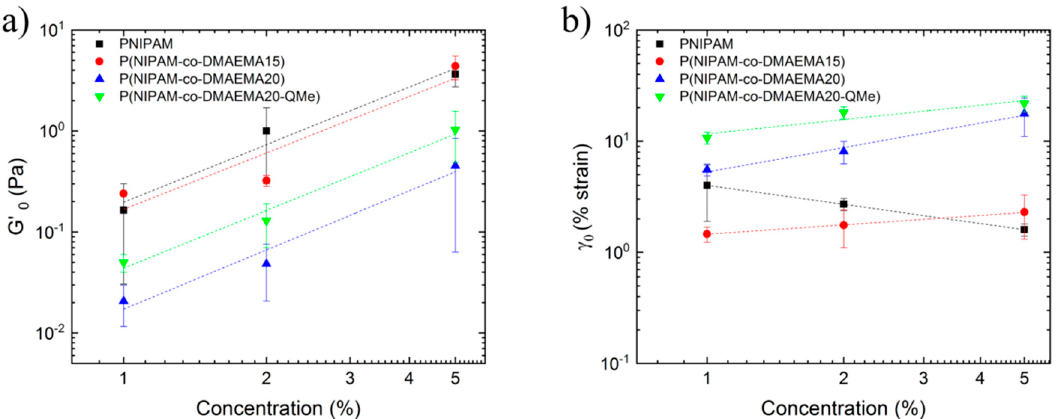
Figure 4. Double-logarithmic plot of ( a ) the elastic modulus plateau, G’ 0 , and ( b ) critical strain, γ 0 , as a function of the microgel concentration for the samples: PNIPAM, P(NIPAM- co -DMAEMA15), P(NIPAM- co -DMAEMA20) and quaternized P(NIPAM- co -DMAEMA20-QMe).